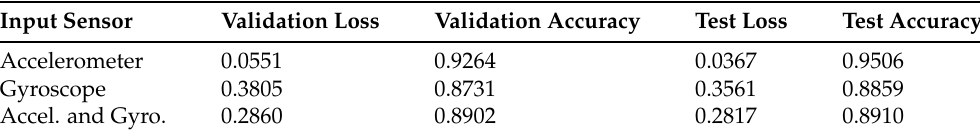
Table 4. Neural network evaluation showing the loss (MSE) and accuracy (Binary) for network using various sensors as input for the training, validation and test